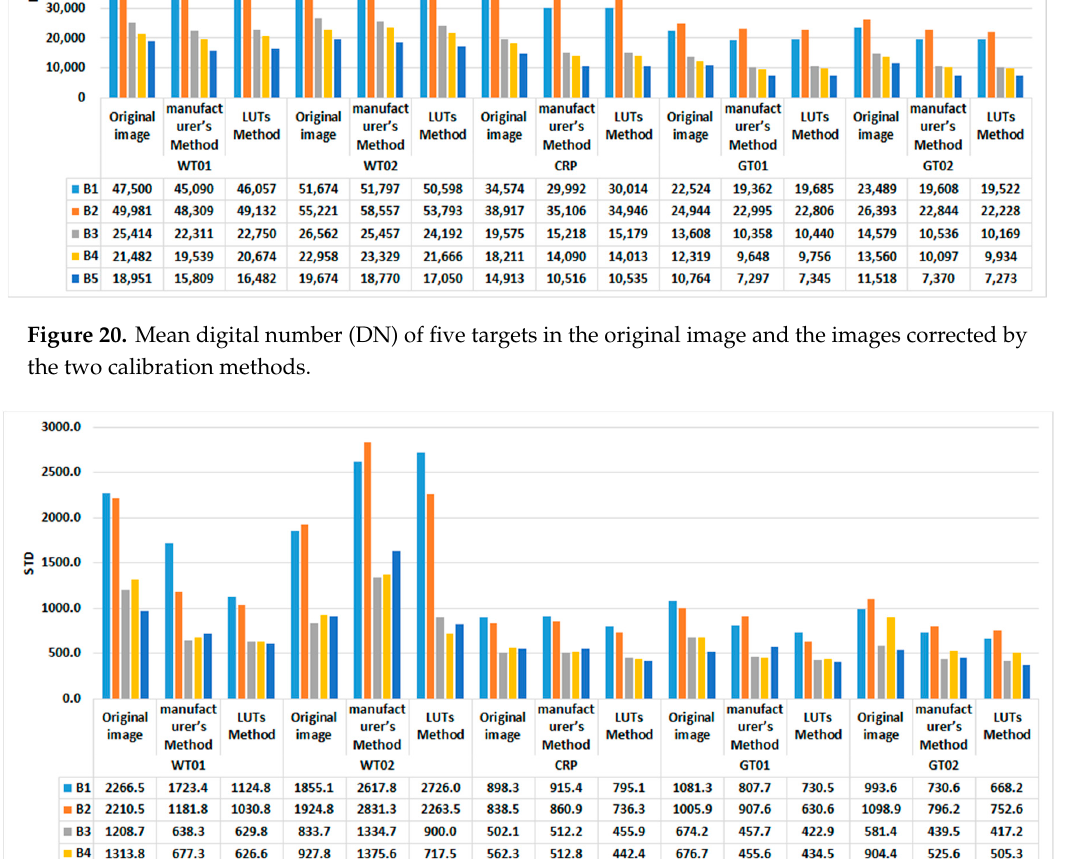
Figure 20. Mean digital number (DN) of five targets in the original image and the images corrected by the two calibration methods.